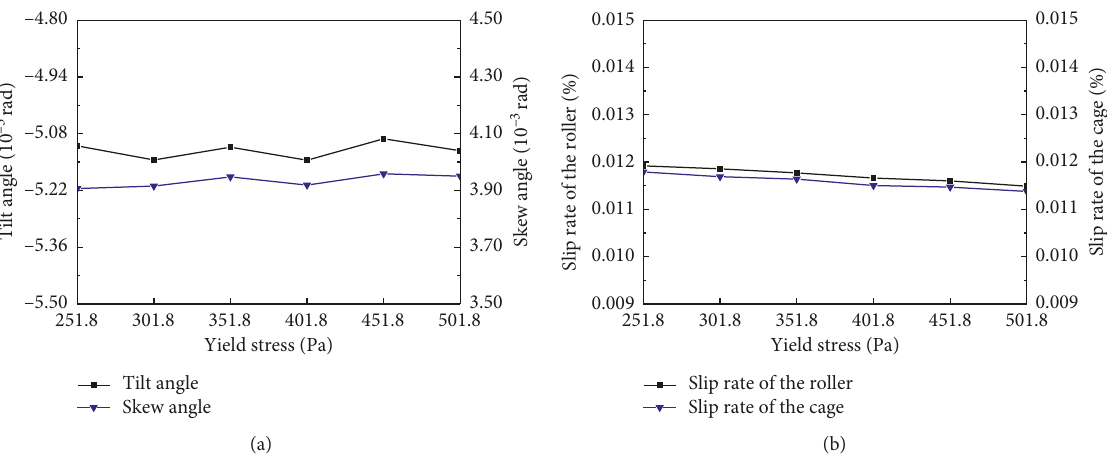
Figure 15: Yield stress influence. F cage.